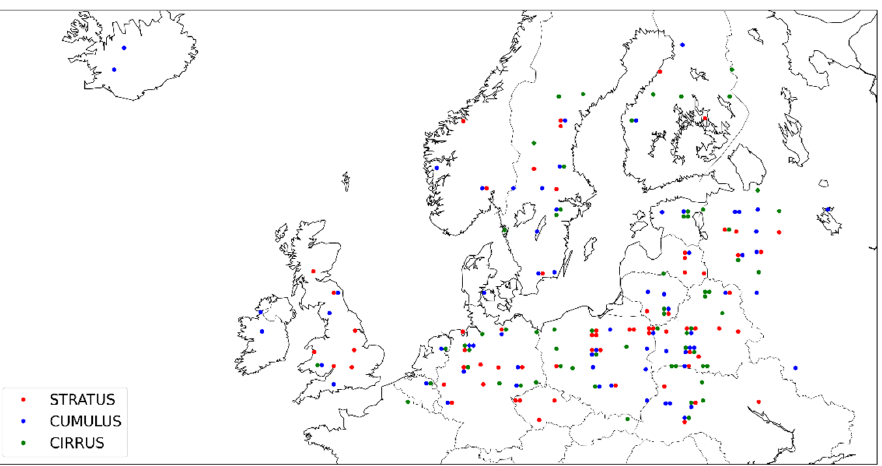
Figure 1. General pipeline of the KappaMask model development.